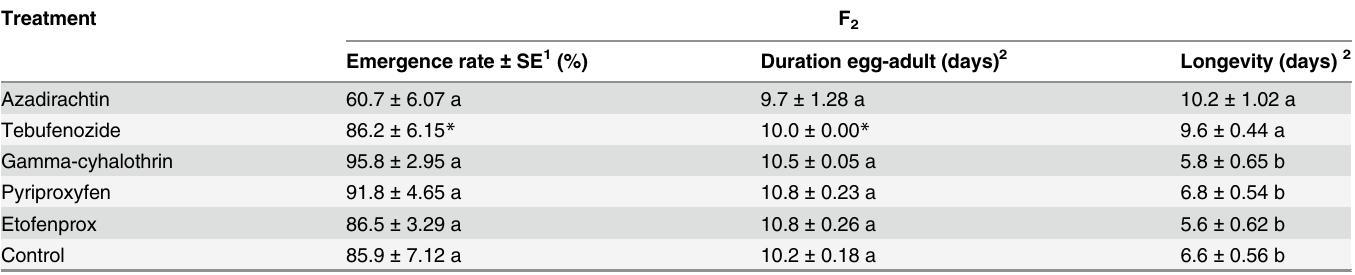
Table 6. Biological parameters of Tamarixia radiata adults of the F 2 generation exposed to residues of different insecticides, and toxicological class proposed by the IOBC/WPRS, under 25 ± 2°C, 70 ± 10% and photoperiod 14 L: 10 D h.